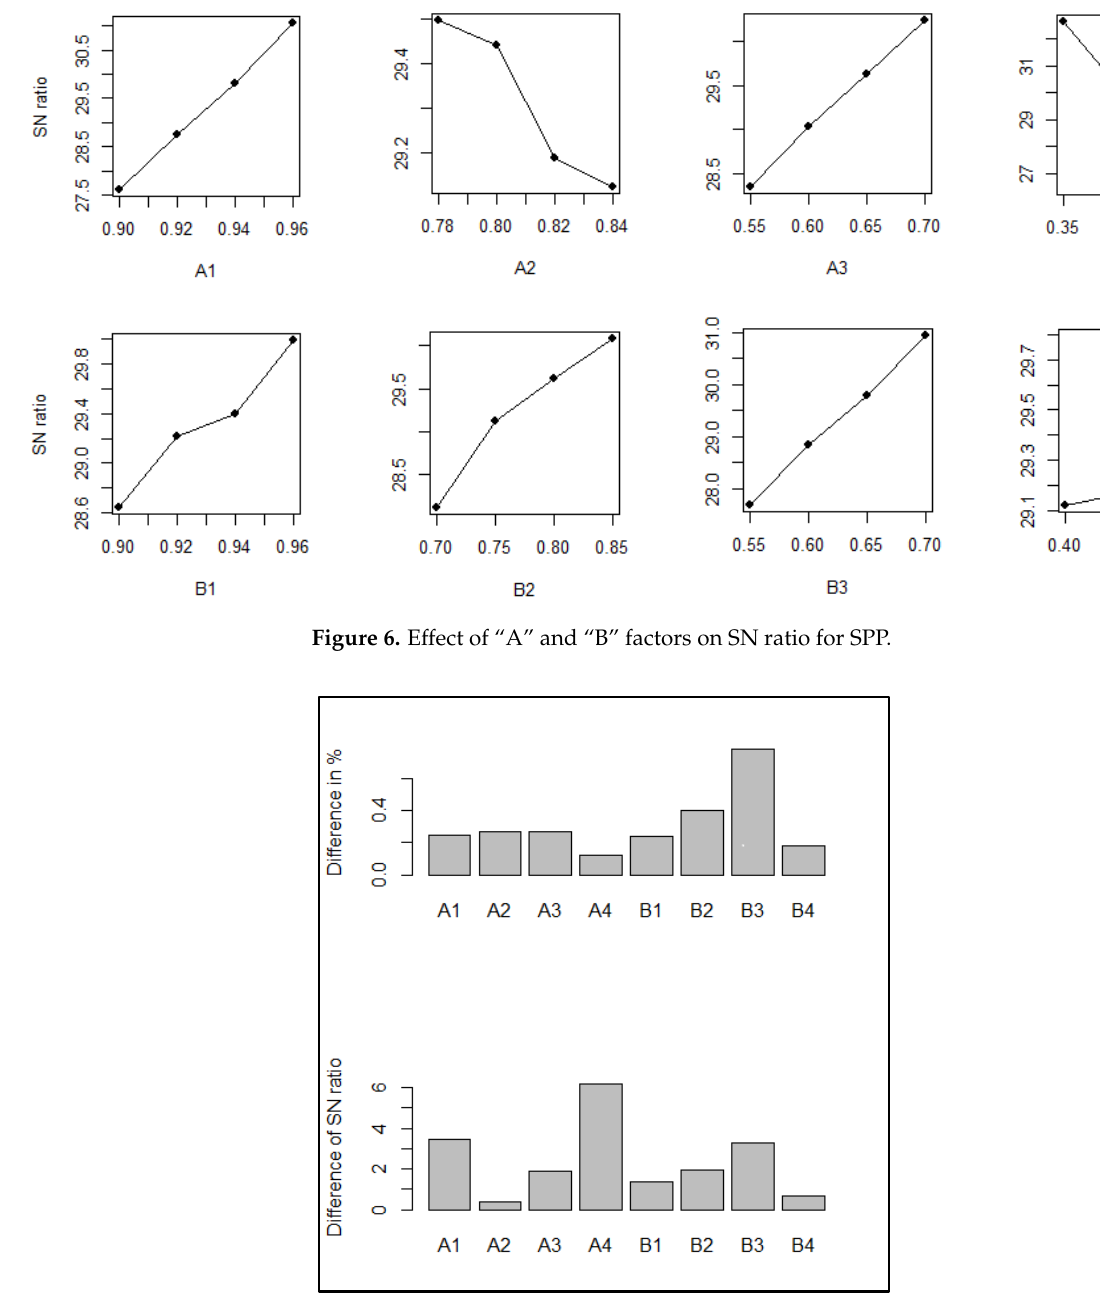
Figure 7. Effect of “A” and “B” factors on average (in %) and the SN ratio of SPP. Assume that the two parties agreed to obtain an average of 3.21% for SPP. There